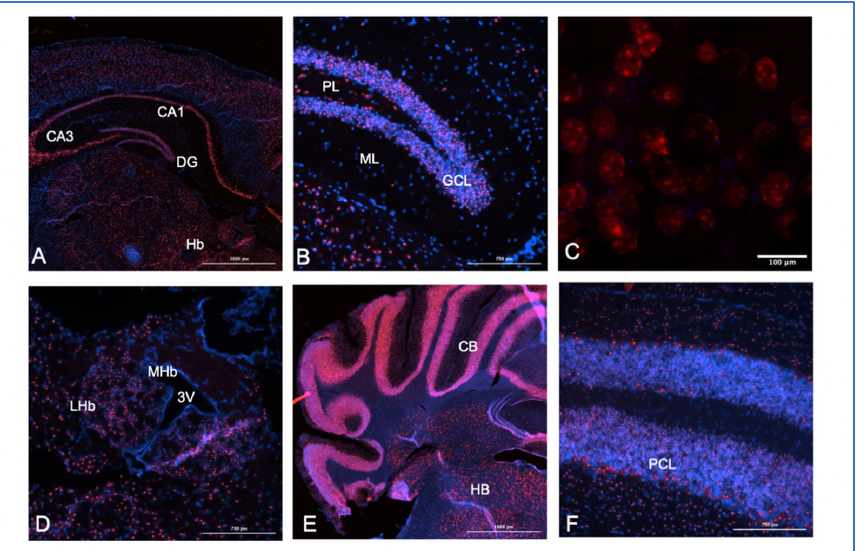
Figure 6. Mouse brain expression analysis for Snhg14. A probe to multiple regions (base pairs 2818–4022 of the NCBI reference sequences, NR_146211.1 and not overlapping any of the known host genes, ACD/Biotechne) for the mouse Snhg14 transcript was used to map expression in brain tissues from perfused animals. Frozen sections (10 mM) from a 28-week-old male mouse were used in the experiments, and all sections were counter-stained with DAPI (blue) with Snhg14 visualized using Opal 620 dyes with a Texas red filter excitation at 560 nm and emission at 610 nm. ( A ) 4X midbrain section showing the CA1, CA3, and dentate gyrus (DG) regions of the hippocampus, along with the habenula (Hb). ( B ) 40X section showing the granular cell layer (GCL), polymorphic layer (PL), and molecular layer (ML) of the dentate gyrus. ( C ) 40X WITH 3X zoom section showing cells in the dentate gyrus. ( D ) Lateral (LHb) and medial (MHb) habenular regions with the third ventricle (3 V). ( E ) Caudal coronal section showing the cerebellum (CB) and hindbrain (HB) regions at 4X. ( F ) 40X section with concentrated expression in the Purkinje cell layer (PCL) of the cerebellum. The high expression of the Snhg14 transcript is also present in the lateral habenula (Figure 6D). The habenula’s role in reward processing for food-motivated behaviors is also consistent with the PWS phenotype. The expression is found in individual cells of the hindbrain and is concentrated in the Purkinje cell layer of the cerebellum (Figure 5D–F). Patients with PWS can have strength and movement deficits that are reflected in lower cerebellar white matter volumes detected by MRI [43,44]. As SNHG14 overexpression in cancer can increase cellular proliferation and migration, it is possible that reduced cell bodies (gray matter) or axons (white matter) in some areas of the brain could be directly due to lack of SNHG14 expression in patients with PWS.